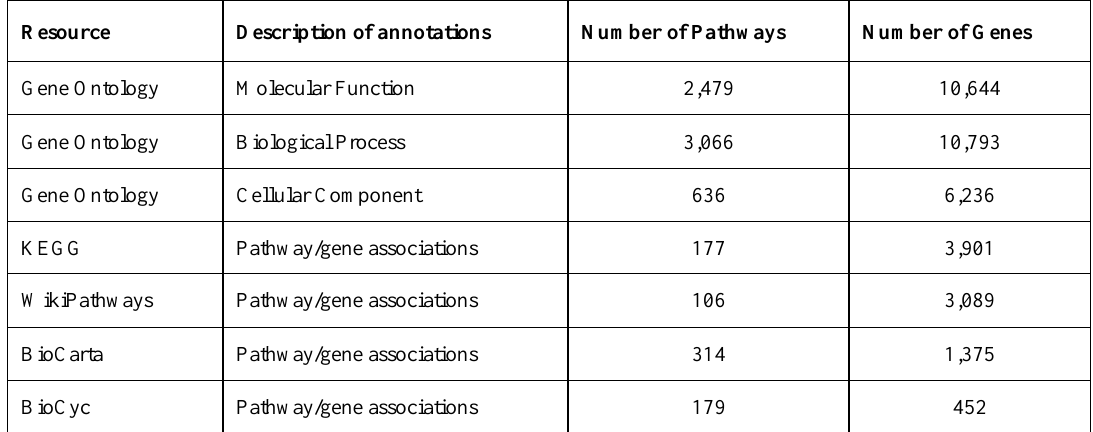
Table 6: Biological pathway resources used for annotation.